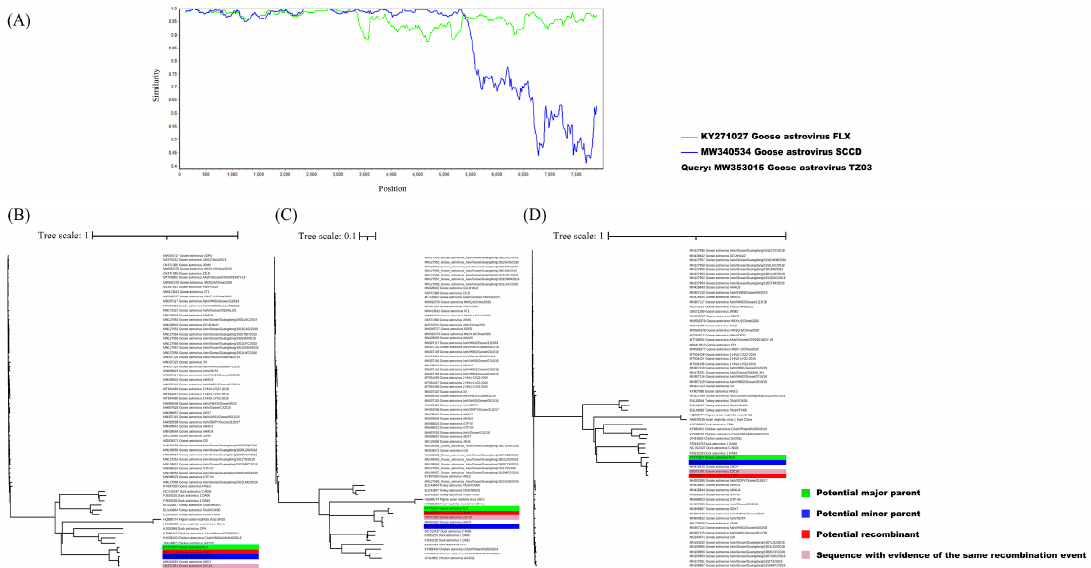
Figure 4. Identification of recombination events between the major parent strain, FLX strain (green), and the minor parent strain, SCCD strain (blue), which led to the recombinant TZ03 (red). ( A ) Simplot evidence for the recombination origin based on the pairwise distance, modeled with a window size of 200, step size of 20, and 100 bootstrap replicates. ( B – D ) A fast neighbor-joining (NJ) tree (1000 replicates, Kimura two-parameter distance) was constructed using the regions derived from the minor parent strain (1–3331 and 5445–8243) ( B ), the non-recombinant region ( C ), and recombination region (3330–5444) ( D ). Note. The potential recombination event was detected using RDP ( p = 3.333 × 10 − 23 ), GENECONV ( p = 1.179 × 10 − 38 ), BootScan ( p = 2.284 × 10 − 50 ), MaxChi ( p = 2.631 × 10 − 12 ), Chimaera ( p = 4.845 × 10 − 5 ), SiSscan ( p = 7.945 × 10 − 53 ), 3Seq ( p = 4.913 × 10 − 52 ) methods.